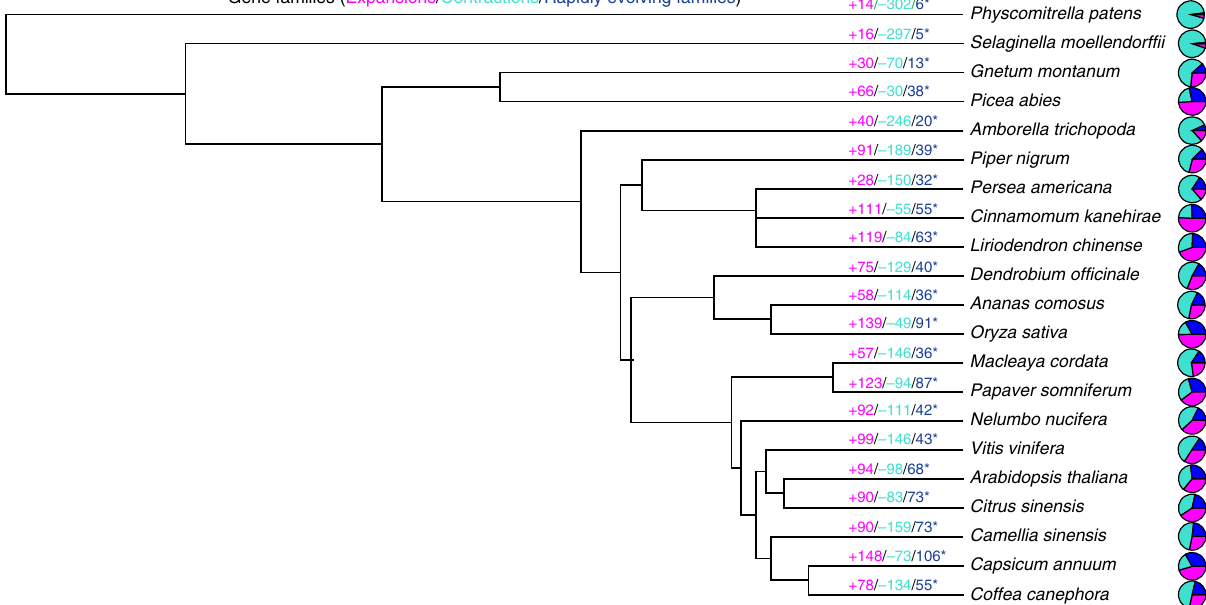
Fig. 3 Estimation of gene family expansion and contraction on each evolutionary branch. Numbers over the branches indicate the number of expansions and contractions in gene families. Magenta indicates the number of expansions, turquoise indicates the number of contractions and blue indicates the number of signi fi cantly ( p -value ≤ 0.01) expanded and contracted gene families. The pie charts on the right show the proportions of these categories. Source data are provided as a Source Data fi